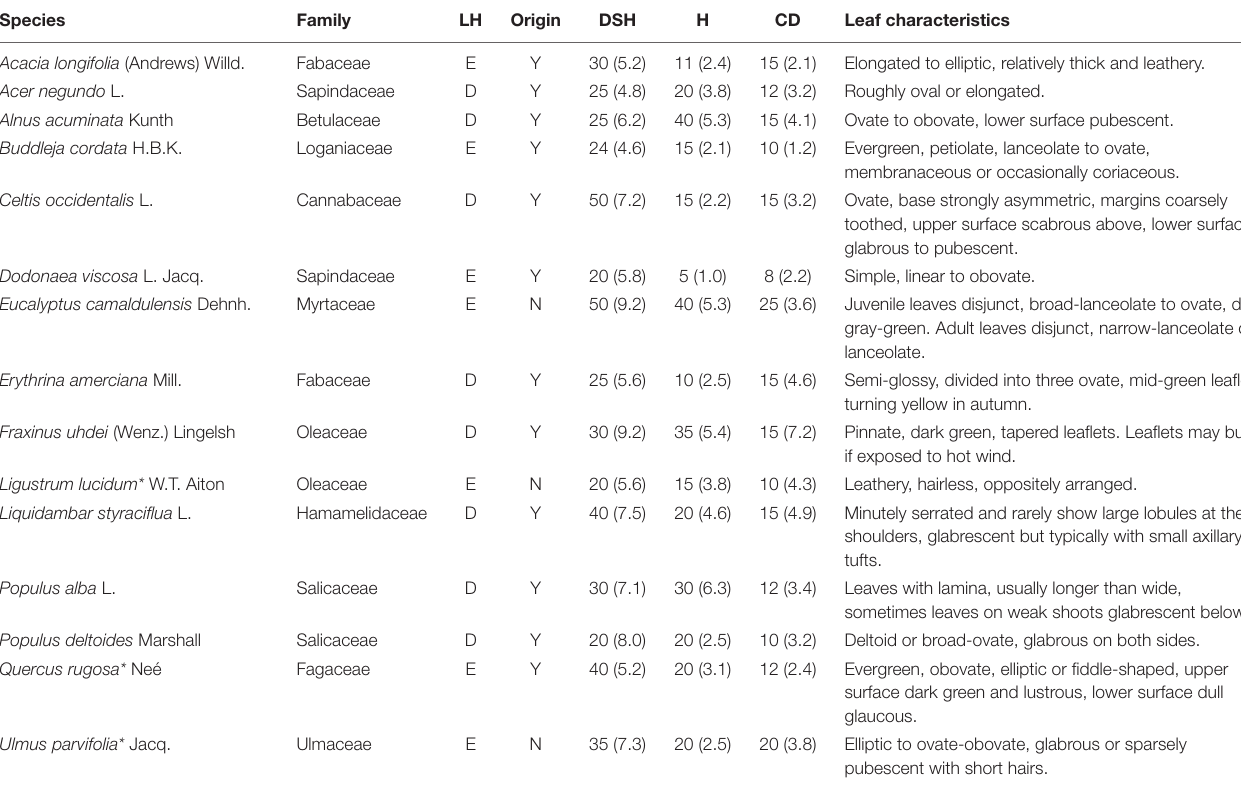
TABLE 1 | Families, leaf habit (LH; D: deciduous, E: evergreen), origin [native to Mexico, yes (Y), no (N)], diameter at standard height (DSH, cm), height (H, m), crown diameter (CD, m) and leaf characteristics for 15 tree species from Mexico City’s urban forest.